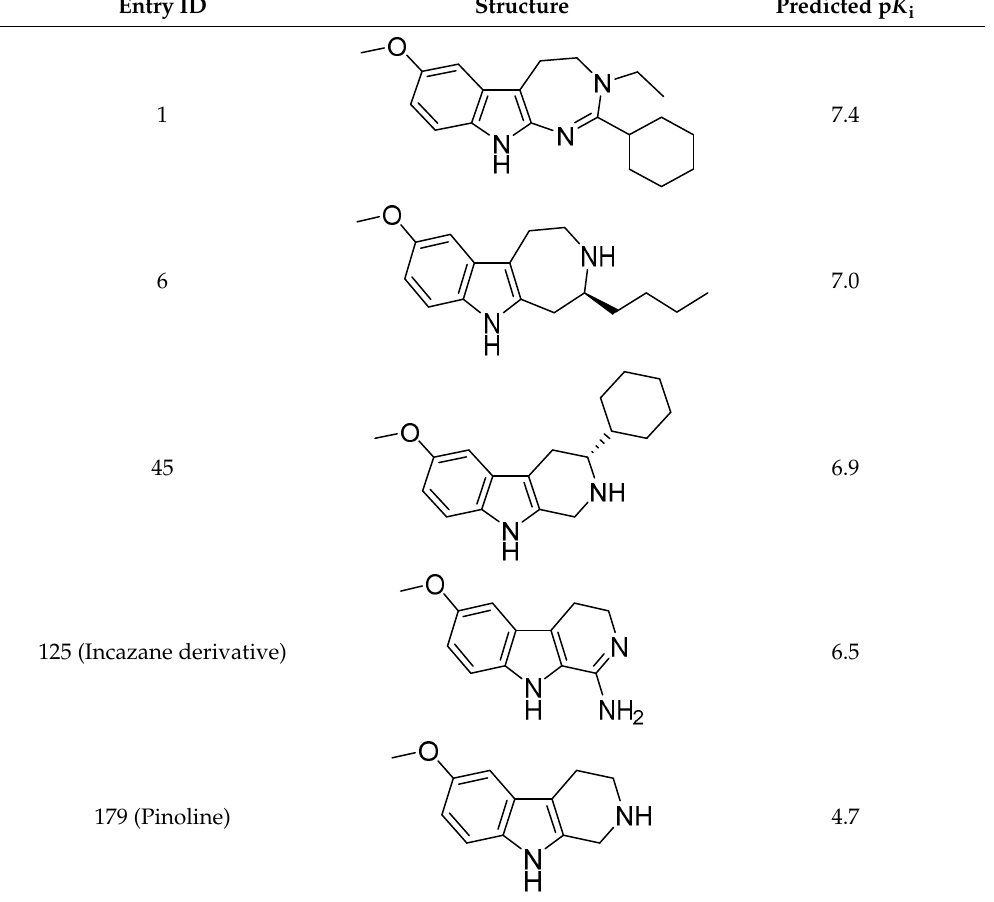
Table 2. Structure and predicted p K i values of the selected ibogaine derivatives resulted from the scaffold-hopping study of Series 2.